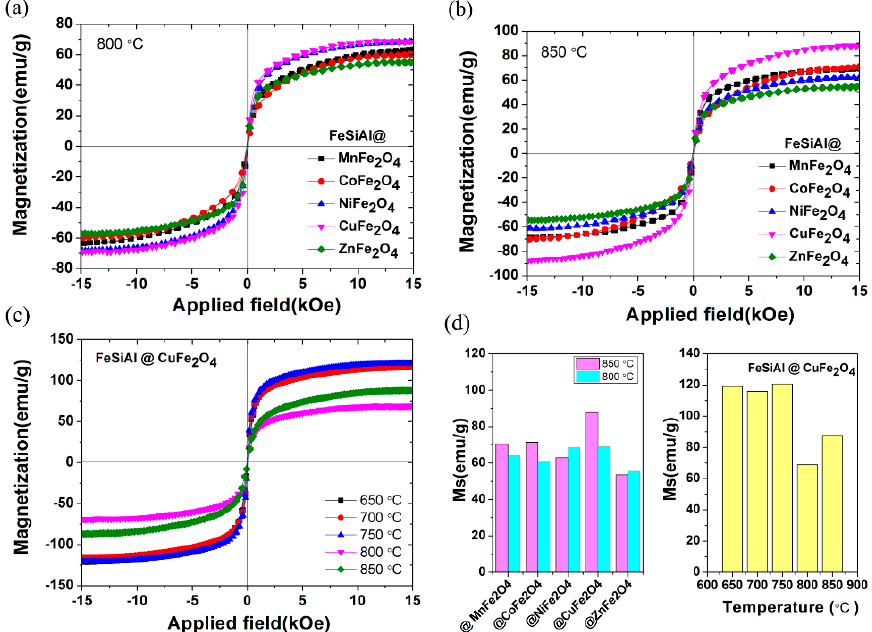
Figure 6. Hysteresis loops of spinel ferrite MFe 2 O 4 (M = Mn, Co, Ni, Cu, Zn)-coated flaky FeSiAl composites annealing at ( a ) 800 °C and ( b ) 850 °C, ( c ) CuFe 2 O 4 coated composites with different annealing temperature and ( d ) saturation magnetization of ( a ), ( b ) and ( c ).